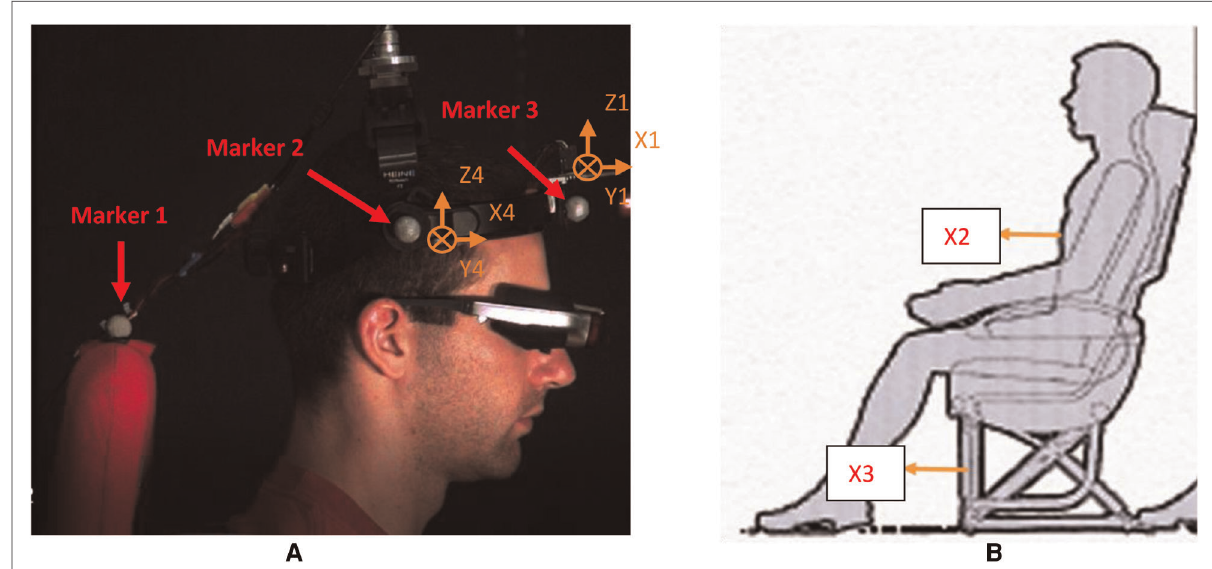
FIGURE 6 Acceleration data collection. ( A ) Accelerometers 1 and 4 on the head. ( B ) Accelerometer 2 on the torso and accelerometer 3 on the sled. Cross lines at 1 and 4 mean that their Y directions point